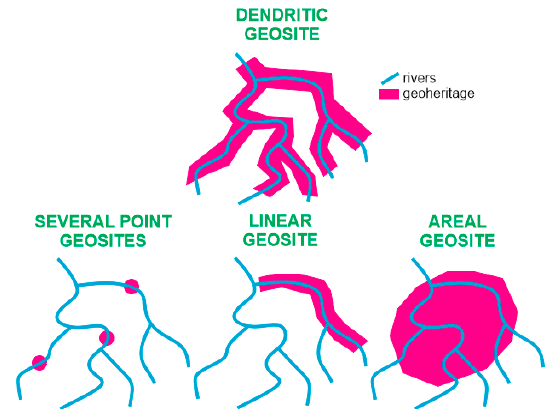
Figure 6. Differences of dendritic geosites from the other categories of geosites.